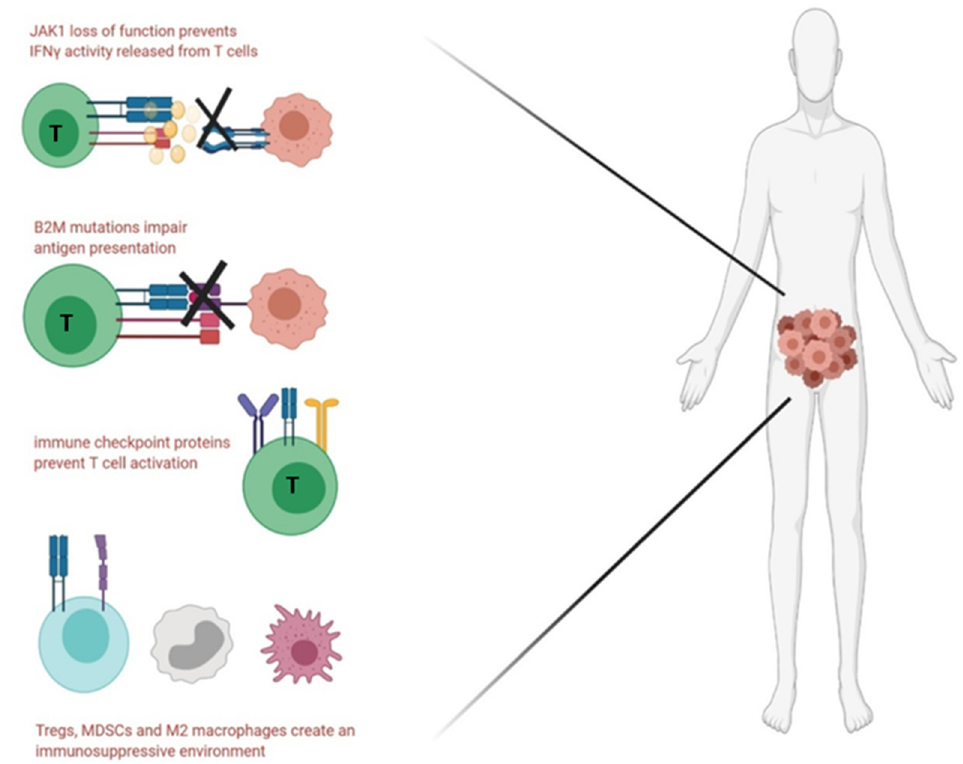
Figure 4. Brief overview of the immune escape mechanisms observed in MSI high CRC. Abbreviations—JAK-Janus Kinase, IFN: interferon, Treg: Regulatory T cells, MDSC: myeloid-derived suppressor cell.